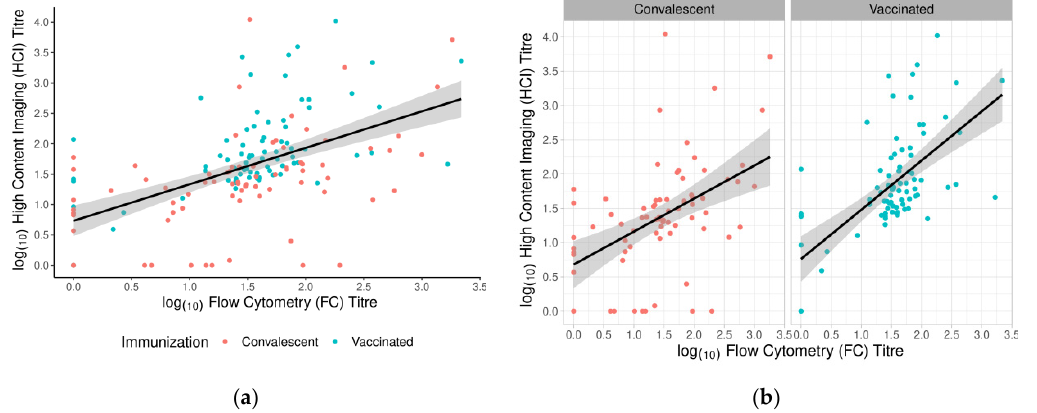
Figure 11. Correlation of neutralising antibody titres defined between FC and HCI for each studied group. ( a ) Log10 transformed values of NT 50 determined in both studied groups. ( b ) Correlation of neutralising antibody levels between two neutralisation assays, in convalescent subjects and vaccinated subjects, separately. Different colour points indicate convalescent (red) and vaccinated (blue) participants. The best-fit linear regression line with the corresponding confidence interval is presented as a black line with a grey band.